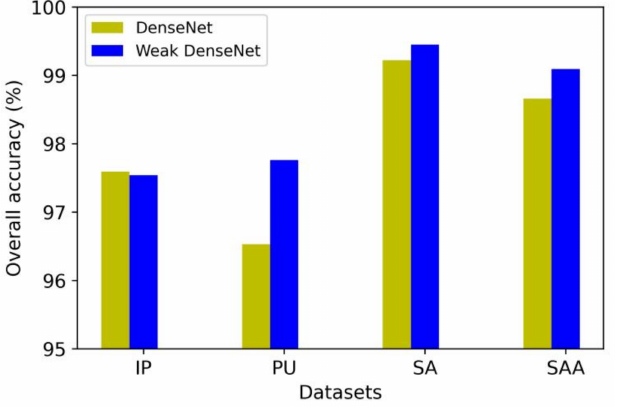
Figure 13. The comparison of weak DenseNet module and DenseNet